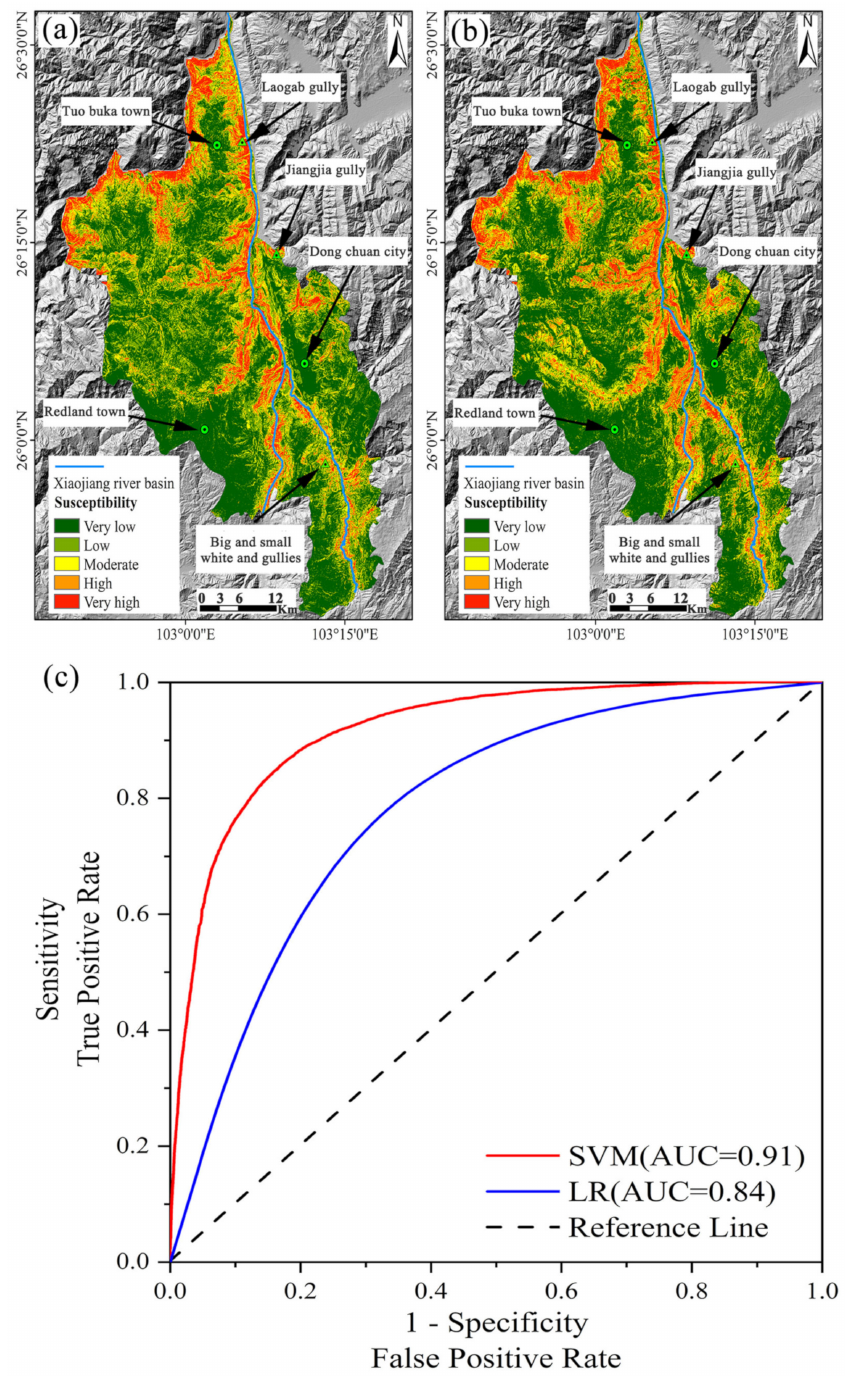
Figure 4. Landslide susceptibility map and ROC curve in the Dongchuan district. ( a ) is the landslide susceptibility map generated by the logistic regression model, ( b ) is the landslide susceptibility map generated by the support vector machine model, and ( c ) is the ROC